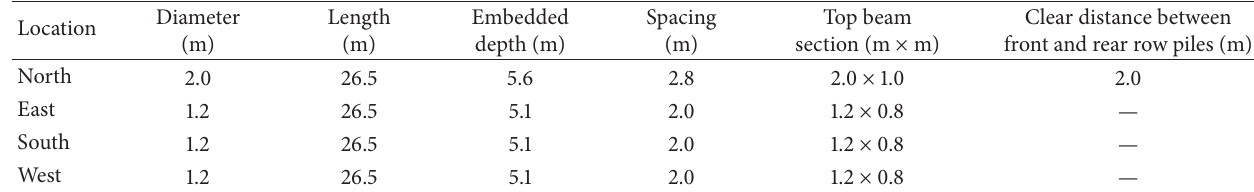
Table 2: Supporting pile body design parameters.